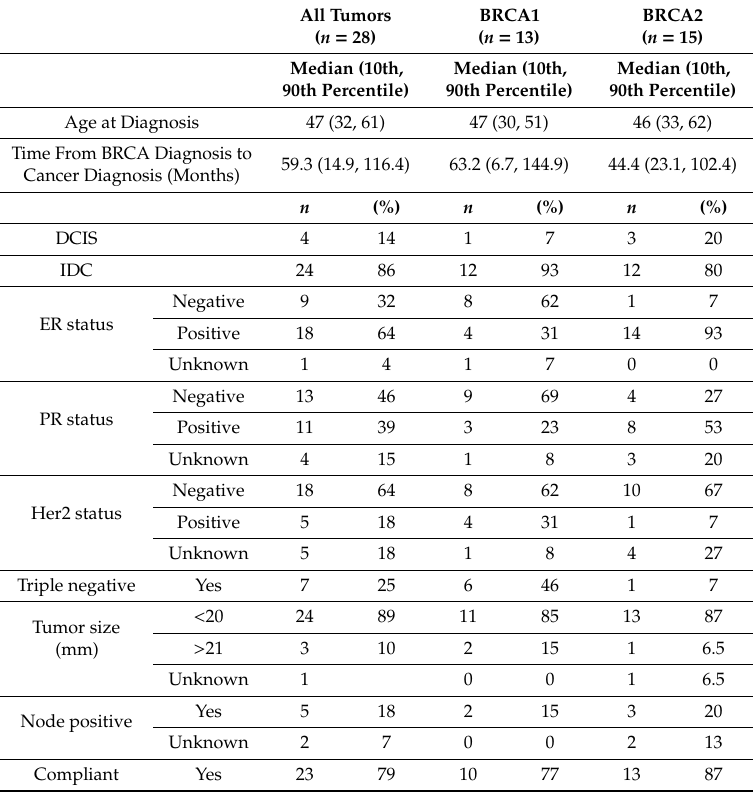
Table 2. Cancer Characteristics: Surveillance Group.